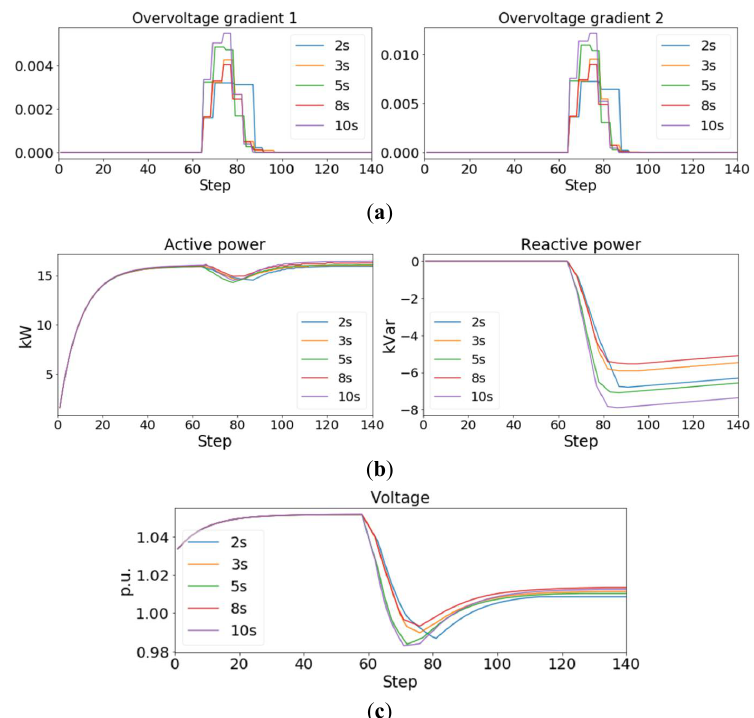
Figure 11. Impact on voltage regulation with different time steps in the local controllers: ( a ) outputs of the coordinator, ( b ) active and reactive power output of a selected PV inverter, and ( c ) voltage measurements.